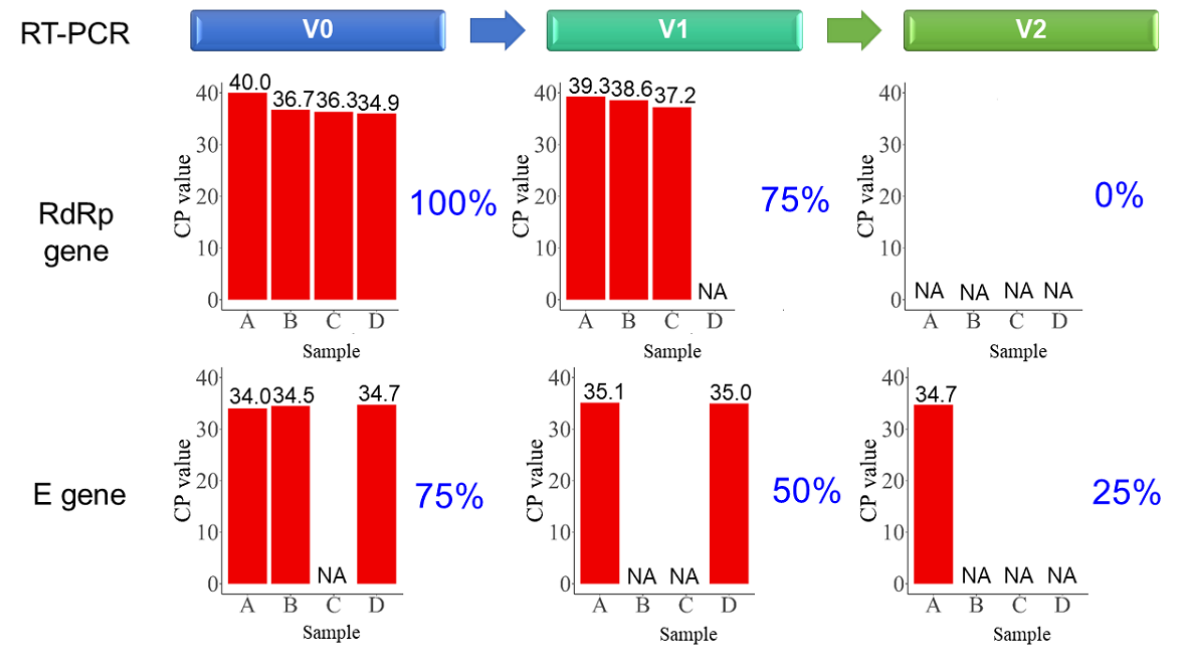
Figure 5. Ex vivo study to determine the efficiency of disinfection of the tablet computer surface. Samples were collected from the tablet surface before disinfection (V0) and after the first and second disinfection processes using 75% alcohol (V1 and V2, respectively). The percentages indicate the positive rate (C P value <45 as positive) of the real time–polymerase chain reaction (RT-PCR, N=4 for each experiment). CP: crossing point. RdRp: RNA-dependent RNA polymerase gene. E: Envelope